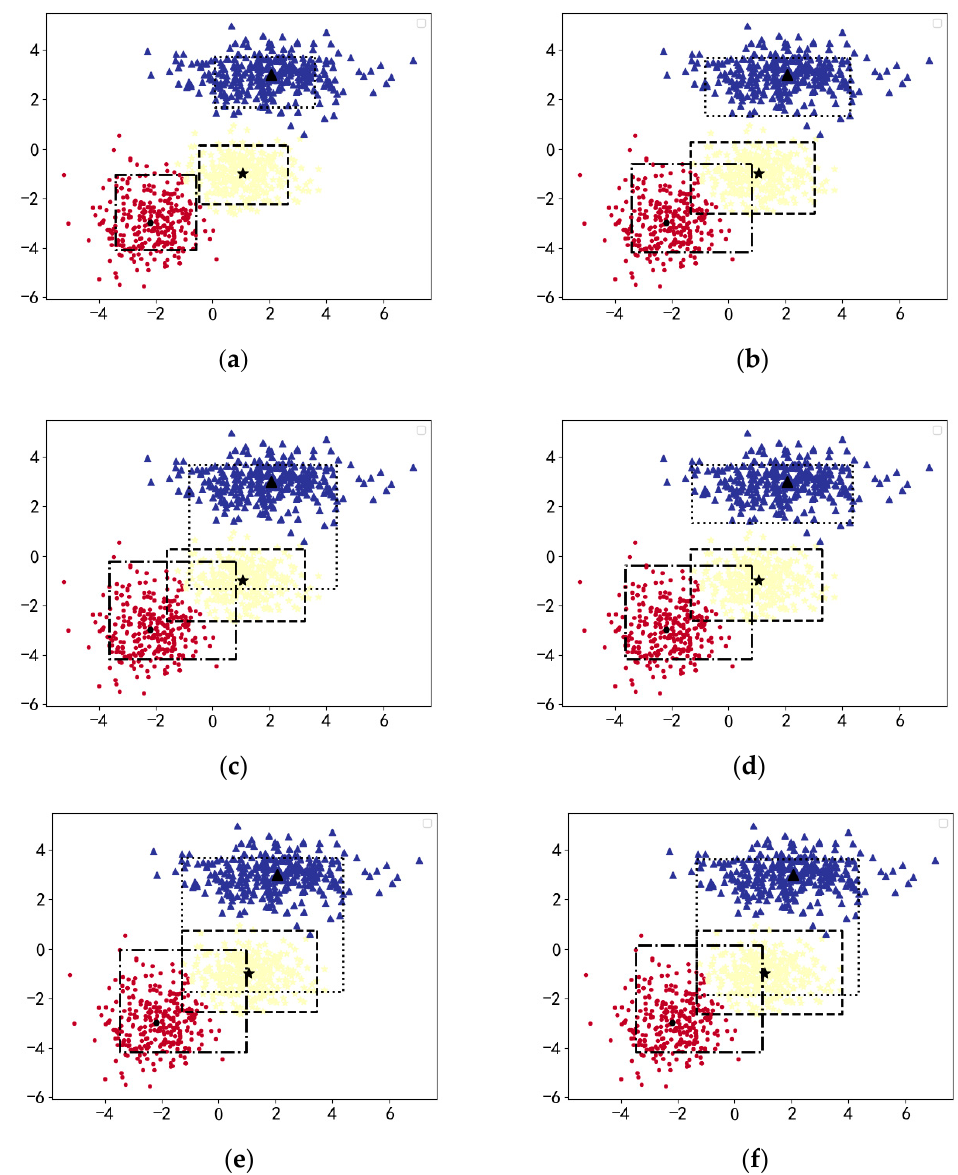
Figure 5. Information granules constructed in a collaborative pattern with different values of parameters α 1 and α 2 ( a ) α 1 = α 2 = 0 ( b ) α 1 = 0.3 α 2 = 0.5 ( c ) α 1 = 0.3 α 2 = 0.8 ( d ) α 1 = 0.5 α 2 = 0.5 ( e ) α 1 = 0.8 α 2 = 0.5 ( f ) α 1 = α 2 = 1